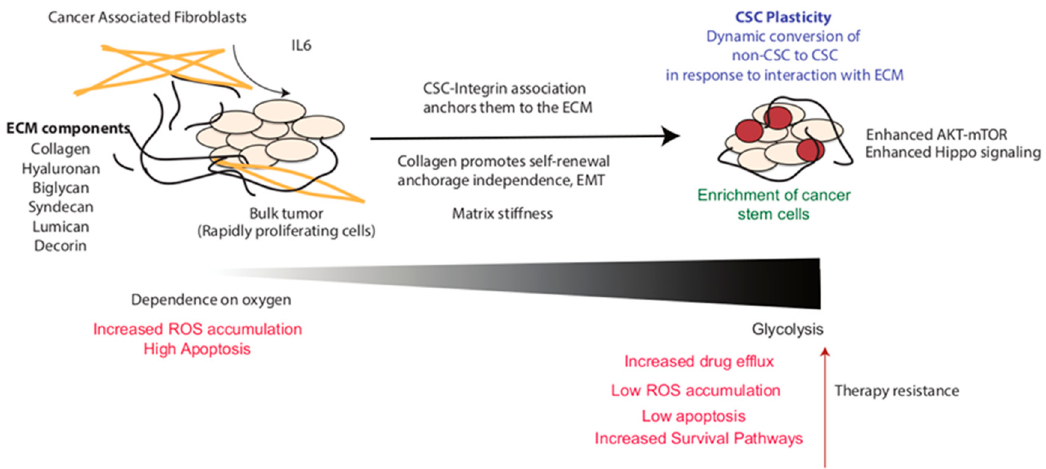
Figure 1. Enrichment of cancer stem cells in the presence of the extracellular matrix (ECM) in the tumor microenvironment. Interaction with the ECM upregulates self-renewal and signaling pathways and induces metabolic reprogramming to enrich therapy-resistant cancer stem cell populations.